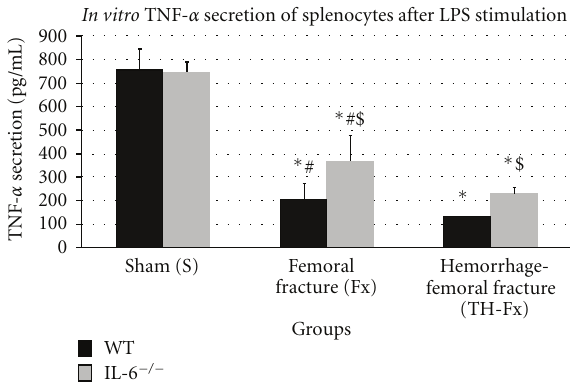
Figure 1: TNF- α productive capacity of splenocytes in response to their stimulation with LPS in wild-type (WT) and IL-6 knockout (IL-6 − / − ) mice in sham animals (group S), after an isolated femoral fracture (group Fx) and after the combination of a femoral fracture and hemorrhage (group TH-Fx). ∗ stat. significance ( P < 0 . 05)